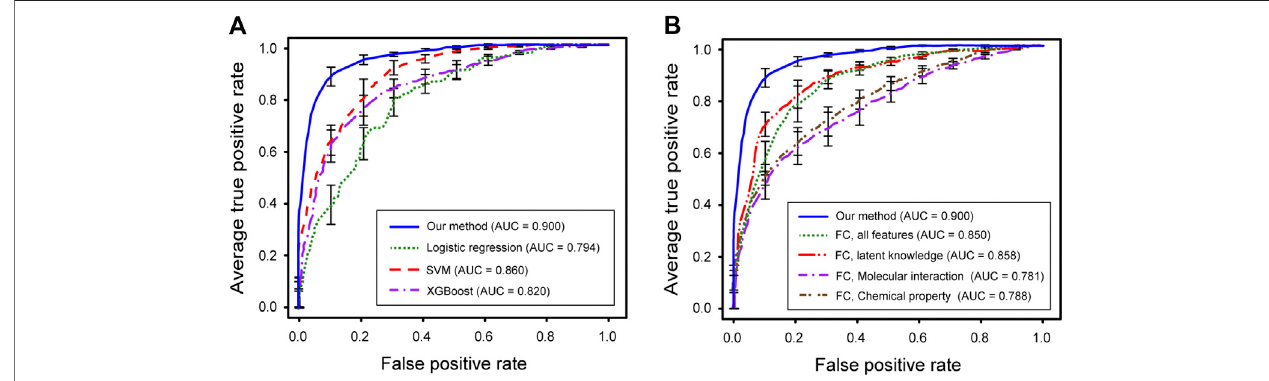
FIGURE 4 | Performance evaluations of predicted medicinal effects of natural compounds. (A) ROC curves for our method (blue), logistic regression (green), SVM (red), and XGBoost (purple). (B) ROC curves for our method (blue), fully-connected using all feature (green), fully-connected only using lagent knowledge (red), fully- connected only using molecular interaction (purple), and fully-connected only using chemical property